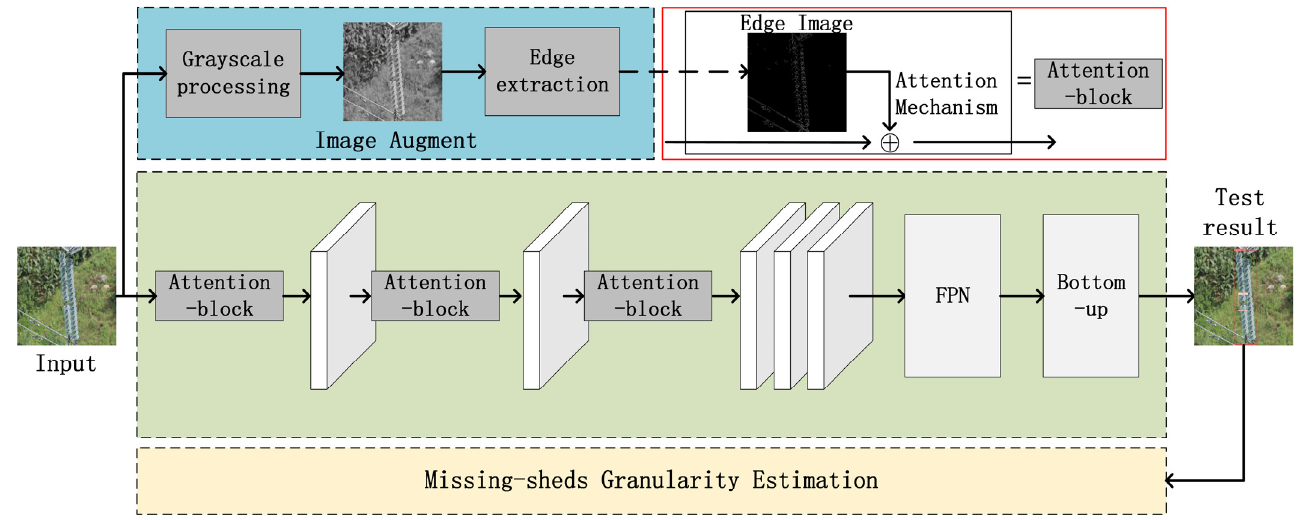
Figure 6. The realization of missing-shed granularity estimation of insulators is divided into three parts: image augment, INSU-YOLO, and missing-sheds granularity estimation, corresponding to image preprocessing, insulator detection, and defect analysis, respectively. First, image augment is used to improve the quality of the input image and provide edge images. We then use INSU-YOLO to obtain detection frames for insulators and defects. Finally, missing-sheds granularity estimation is used to analyze the degree of defects.